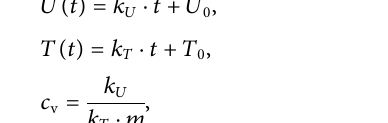
value, is plotted against the channel heights in the inset of fi ned in copper Figure 2 , and values of c normalized of water con nanochannels (ratio to the fi tted asymptotic value) ranging from 50 Å to 800 Å (Jin et al., 2021) are plotted in this inset as well for comparison. It is found that c v of con fi ned water is lower